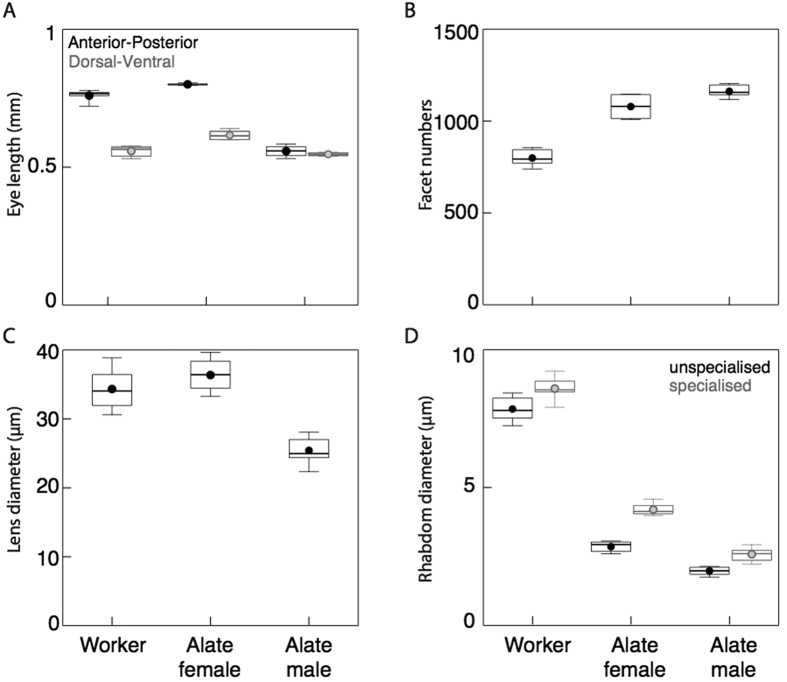
Properties of the compound eye of workers, alate females and males of Camponotus consobrinus ants.Box plots show variation in (A) eye length, (B) facet numbers, (C) lens diameter and (D) rhabdom diameter of workers, alate females and alate males. Each box plot shows the 75th percentile (top line), 25th percentile (bottom line), median (thick line in the middle), mean (filled circle). Whiskers show the 10th and 90th percentile of the data.